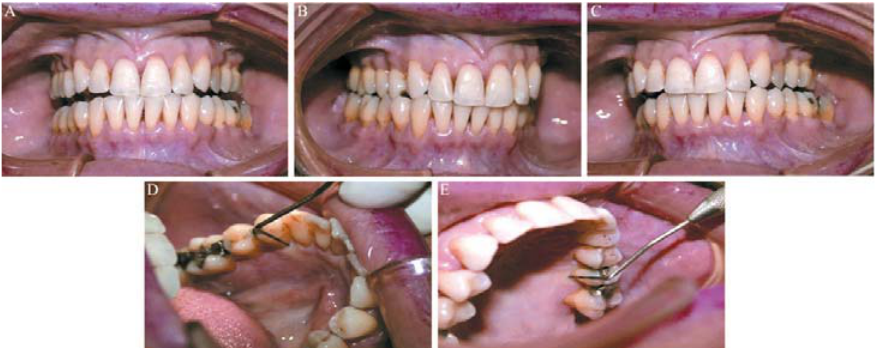
Figure 3- (cid:2)=(cid:7)(cid:7)(cid:4)(cid:12)(cid:14)(cid:8)(cid:4)(cid:2)(cid:9)(cid:10)(cid:8)(cid:11)(cid:12)(cid:13)(cid:10)(cid:14)(cid:2)(cid:15)(cid:9)(cid:2)(cid:11)(cid:16)(cid:10)(cid:2)(cid:2)(cid:6)(cid:15)(cid:6)(cid:17)(cid:5)(cid:6)(cid:18)(cid:8)(cid:19)(cid:19)(cid:8)(cid:11)(cid:15)(cid:13)(cid:20)(cid:2)(cid:21)(cid:10)(cid:14)(cid:11)(cid:13)(cid:12)(cid:7)(cid:11)(cid:5)(cid:22)(cid:10)(cid:2)(cid:23)(cid:10)(cid:13)(cid:5)(cid:15)(cid:21)(cid:15)(cid:6)(cid:11)(cid:8)(cid:4)(cid:2)(cid:21)(cid:5)(cid:14)(cid:10)(cid:8)(cid:14)(cid:10)(cid:2)(cid:24)(cid:25)(cid:26)(cid:27)(cid:28)(cid:27)(cid:29)(cid:2)(cid:7)(cid:8)(cid:14)(cid:10)(cid:30)(cid:2)(cid:25)(cid:15)(cid:11)(cid:10)(cid:2)(cid:8)!(cid:14)(cid:10)(cid:6)(cid:7)(cid:10)(cid:2)(cid:15)(cid:9)(cid:2) defective protrusion (A) or laterality movements (B, C). Occlusion records with no premature or abnormal contacts on occlusion can also be observed (D,